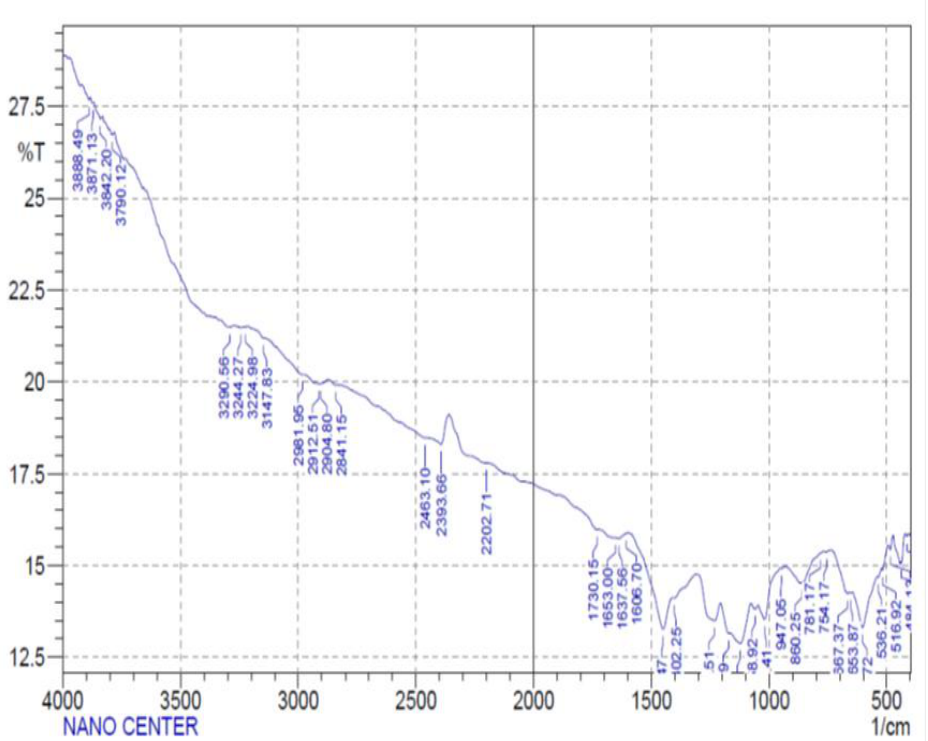
Fig. 6: FTIR spectra of synthesis of